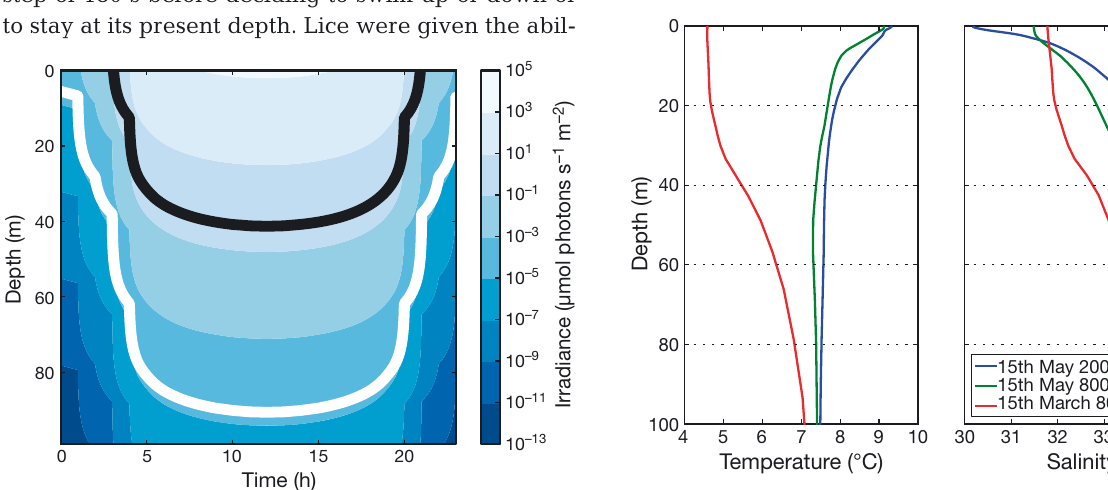
Fig. 3. Simulated diurnal irradiance for the date 1 May at 60°N. Thick solid lines represent the assumed light-detection threshold for Lepeophtheirus salmonis copepodites (white line) and nauplii (black line). Time: hours past midnight